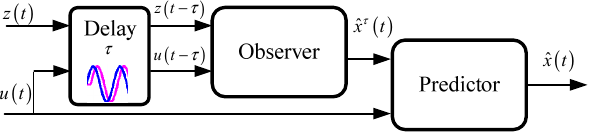
Figure 7. Delayed observer and predictor structure.